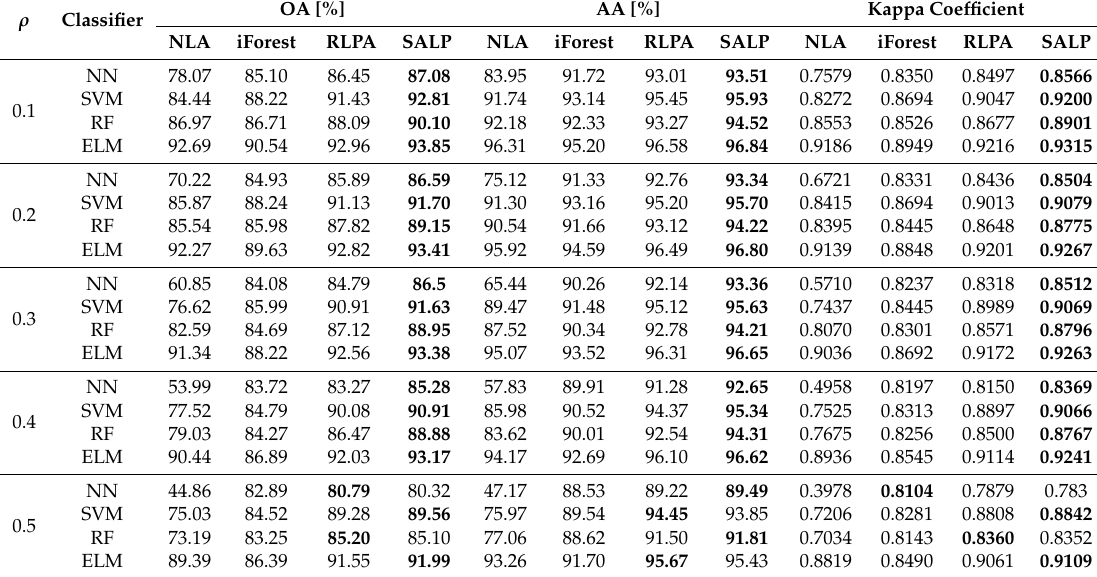
Table 2. Comparisons of baselines and SALP over four typical classifiers with the “random” Setting on the Salinas dataset. The best results are